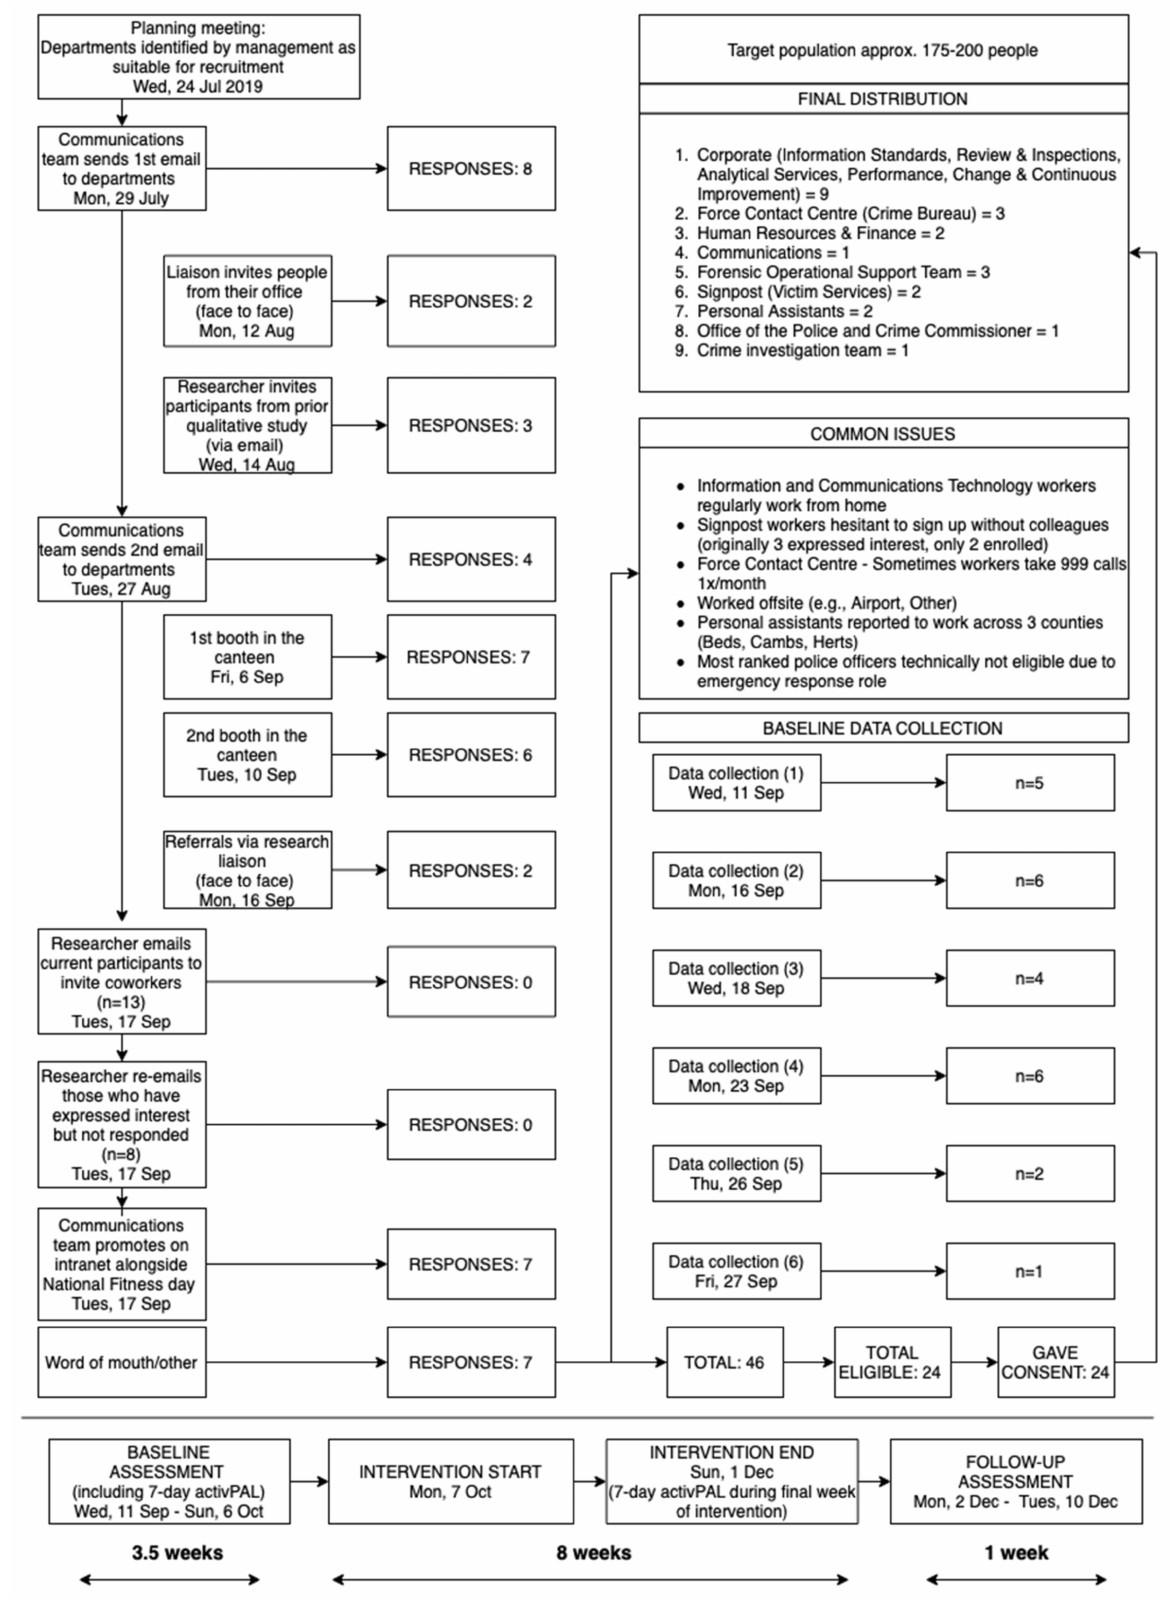
Figure 1. Flowchart detailing recruitment, response rates, baseline data collection attendance, and study